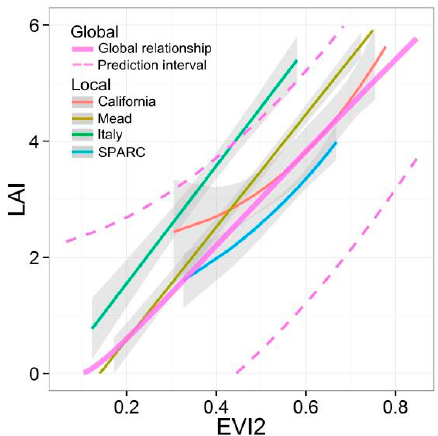
Figure 8. Local LAI-EVI2 relationships of maize for four major sites compared to the global maize relationship. The thin colored lines are the best-fit functions for each site. The thick solid rose-colored line refers to the global relationship, with dashed rose line being the prediction interval. Gray shaded areas are the 95% confidence